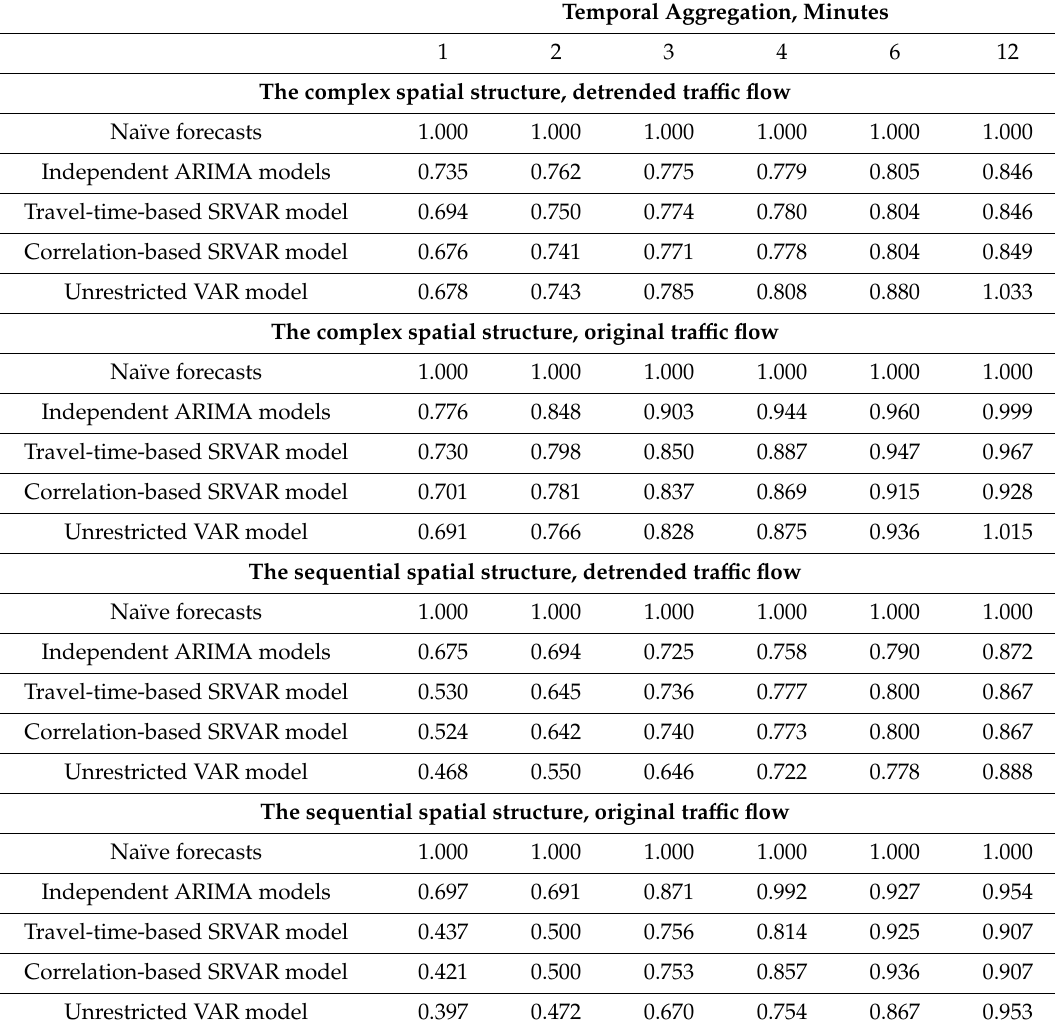
Table 3. Mean absolute scaled error (MASE) values for one-step ahead forecasts for di ff erent temporal aggregation